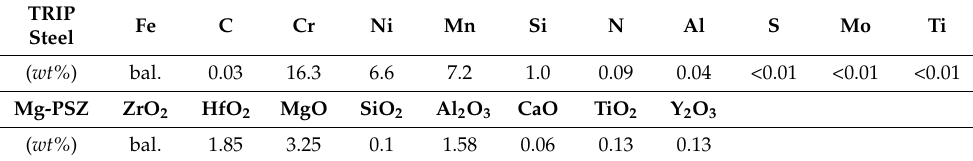
Table 1. Nominal chemical compositions of transformation-induced plasticity (TRIP) steel and Mg-PSZ powders. TRIP Steel Fe